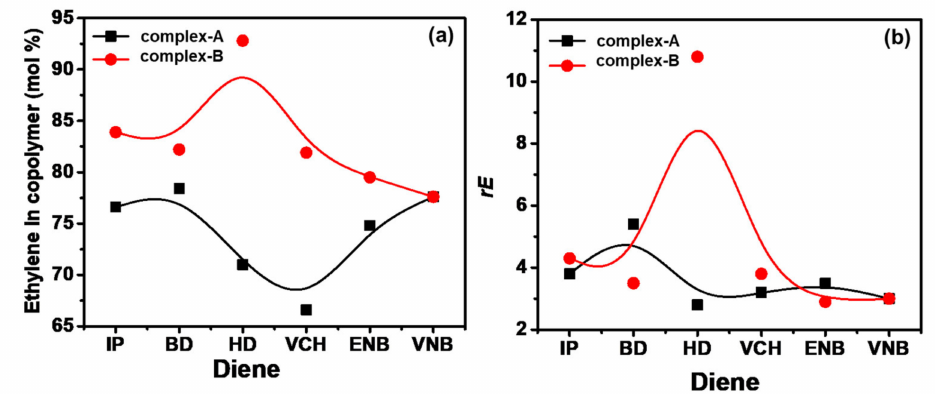
Figure 11. ( a ) Ethylene content in terpolymer produced with conjugated and nonconjugated dienes; ( b ) change in reactivity ratio rE in terpolymers with the addition of